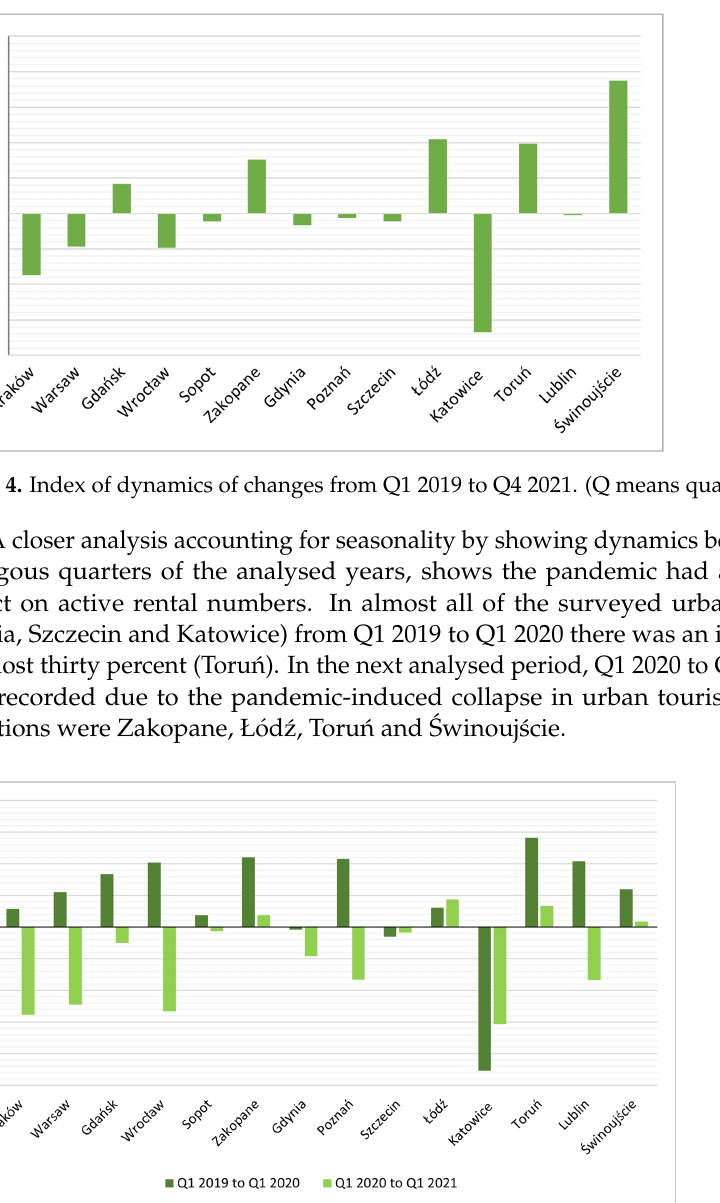
Figure 5. Indices of dynamics of changes, Q1 2019 to Q1 2020 and Q1 2020 to Q1 2021.